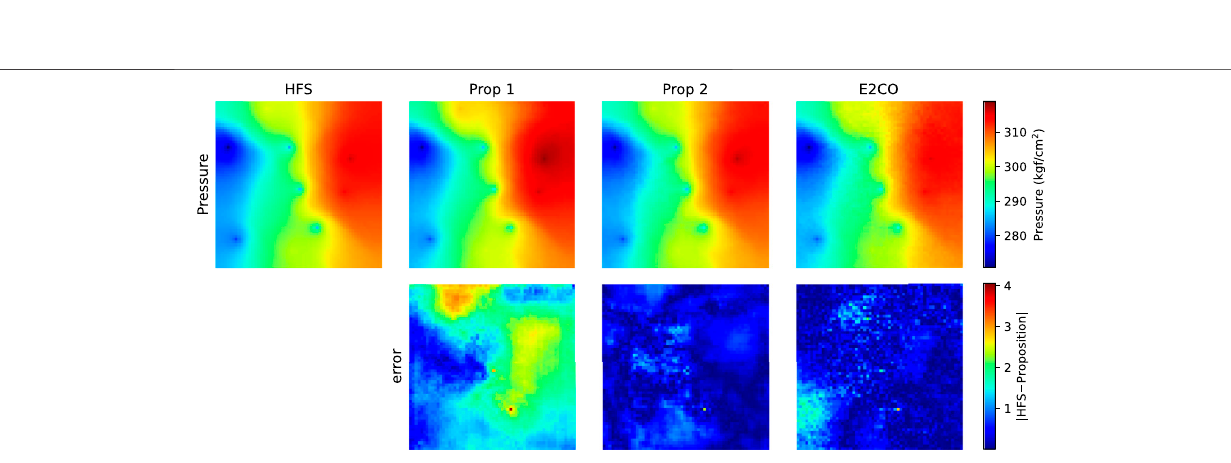
FIGURE 20 | Pressure map for the last predicted time step of validation sample